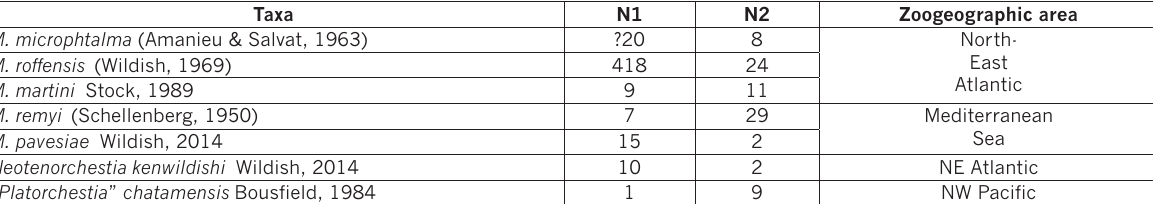
Table 2. List of the known species of driftwood specialist talitrids recognized by 2017. N1 is the number of individuals reported as type material, N2 is the number of references which include each named species in the biological study reported. See Supplementary List for the full list of